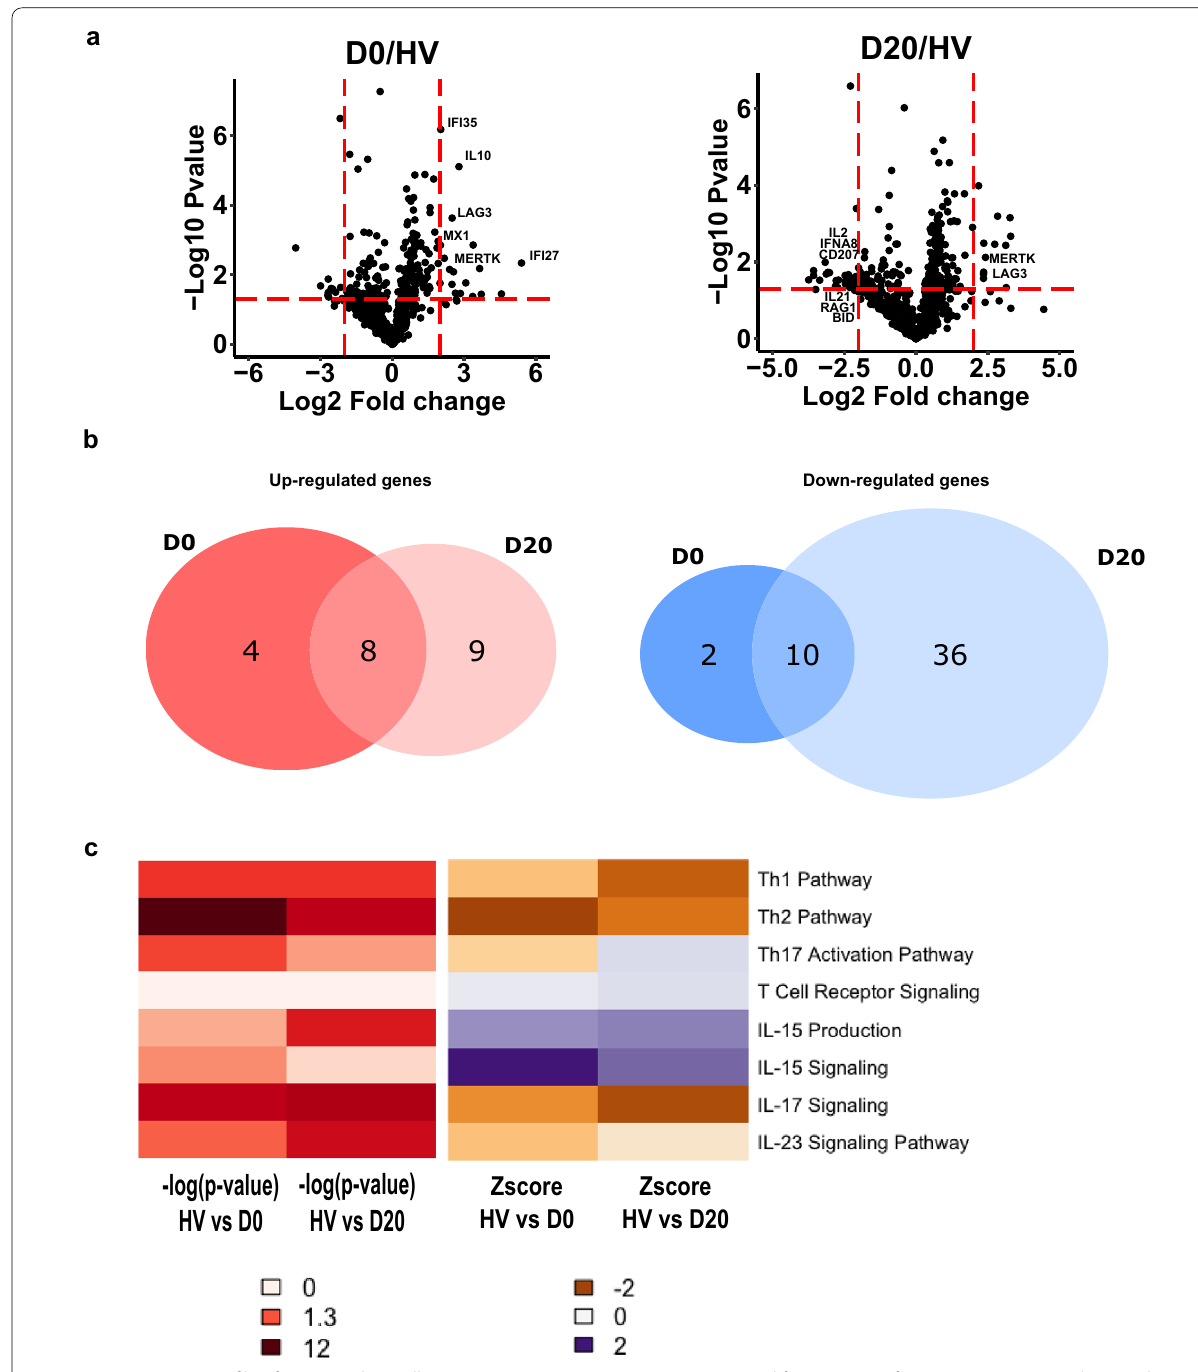
Fig. 1 Transcriptomic profile of mononuclear cells in severe COVID‑19 patients. RNA extracted from PBMCs of COVID‑19 patients at day 0 and day 20 ( n 10) and healthy volunteers (HV, n 10) was analyzed through NanoString technology. a Volcano plots of differentially expressed = = genes between patients sampled at D0 or at D20 and HV are showed. Limits of significance are illustrated by red dotted lines (i.e. Log2 Fold Change 2 or 2 and Log 10 P value 1.3). Selected genes are mentioned. b Venn diagrams of significantly up‑regulated (left diagram, n = − + − = or down‑regulated (right diagram, n 48) genes between patients and HV are showed. c Ingenuity Pathway Analysis was applied on the list of = differentially expressed genes at D0 and D20. Heatmaps of Log 10 P ‑value (from white indicating the absence of significance to dark red indicating a strong significance) and Z ‑score (from orange indicating a down‑regulation to purple indicating an up‑regulation) for pathways related to T cell activation at D0 and D20 are